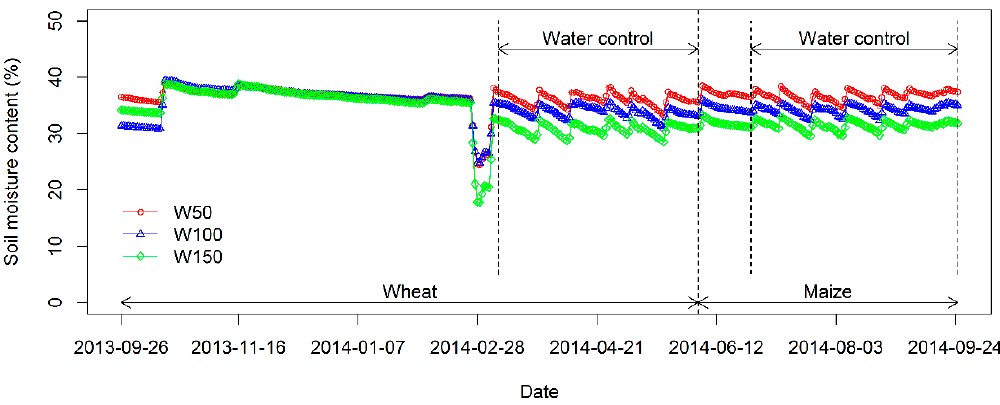
Figure 5. The soil moisture content changes observed in the lysimeter experiments during the wheat and maize seasons. Soil water deficits in lysimeters compared to field water capacities were controlled to 50 ± 15 mm (W50), 100 ± 15 mm (W100), and 150 ± 15 mm (W150) during water control terms.